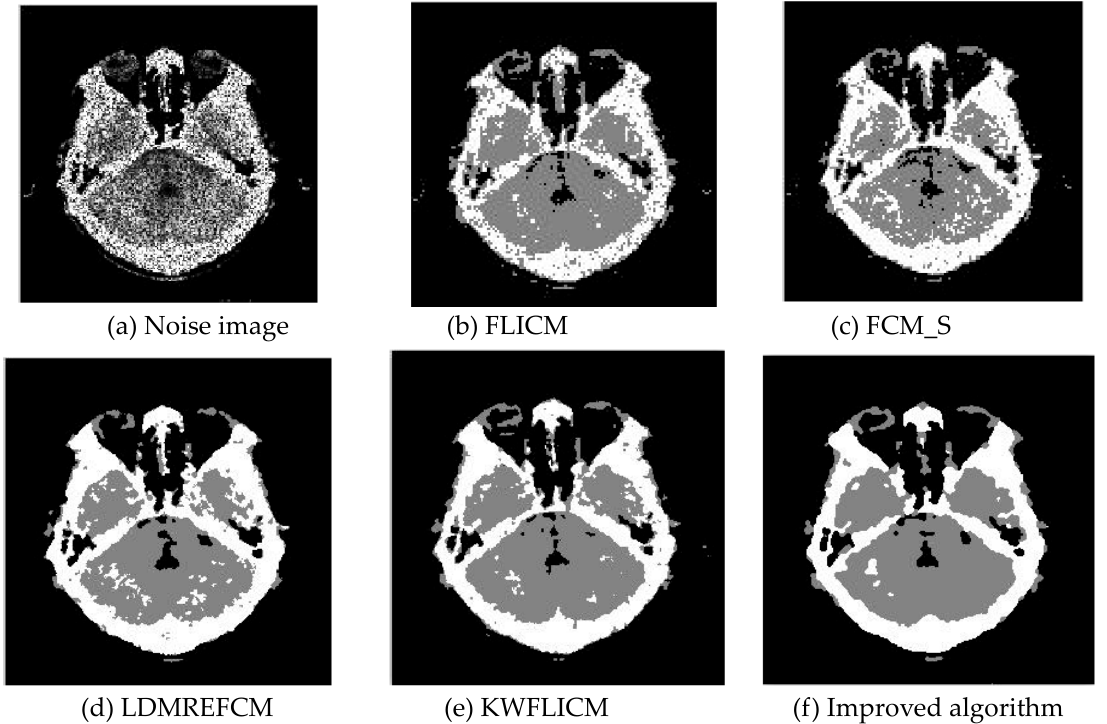
Figure 12. Multiplicative noise disturbing brain CT images ( a ) and the segmentation results ( b – f ).